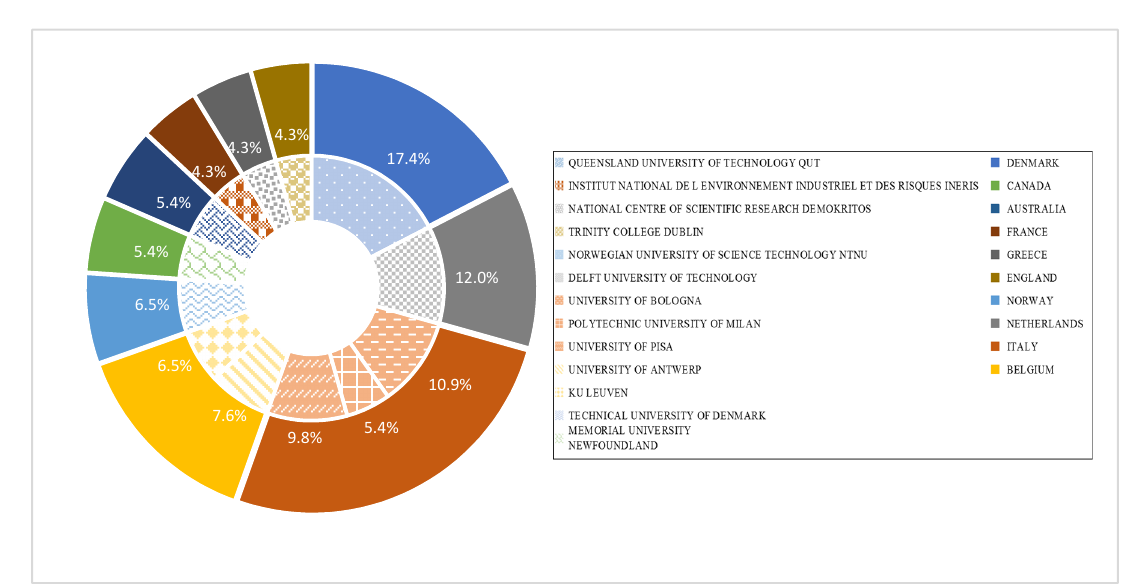
Figure 5. Distribution of authors’ affiliations.